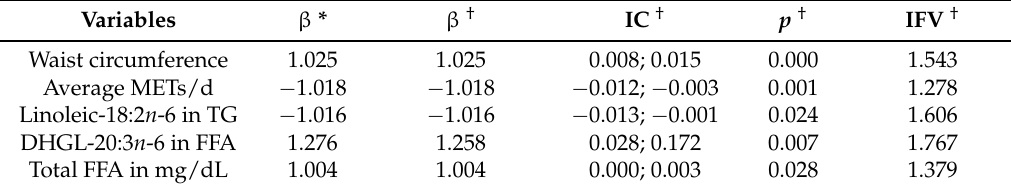
Table 5. Multiple linear regression model with explanatory variables of the HOMA